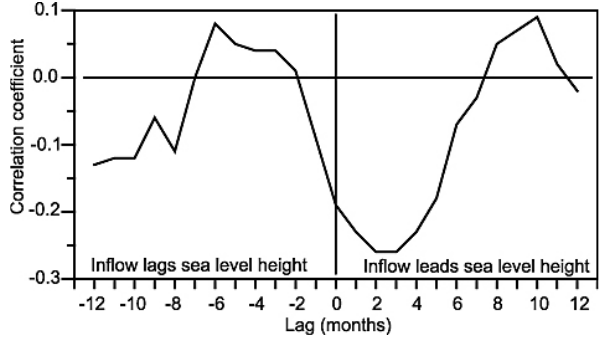
Fig. 12. Correlation coefficient between monthly averaged IF- inflow and SLH upstream of the IFR, h u , lagged from − 12 to +12